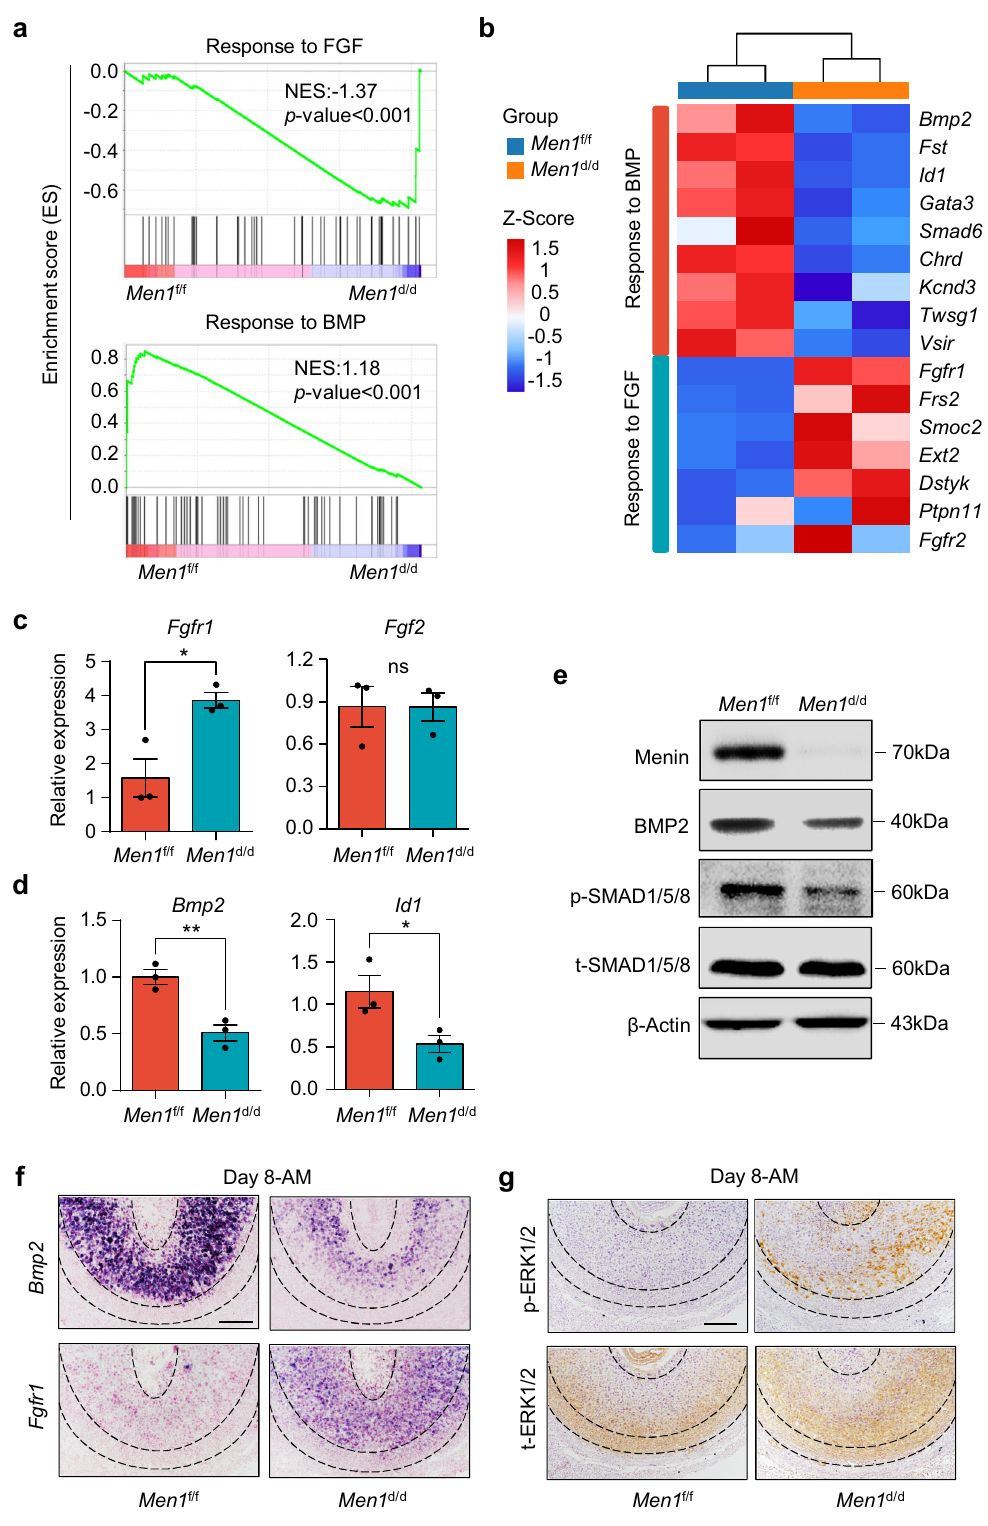
Among the direct targets marked by Menin-H3K4me3 during stroma decidualization, Ptx3 involved in decidualization regula- tion possesses speci fi c expression pattern in the SDZ 41 , but its physiological signi fi cance in stromal cell differentiation remains intangible. Several pieces of evidence showed that PTX3 acted as a natural FGF2 trap through its N-terminal domain to sequester FGF2-ERK1/2 signaling from promoting cell proliferation 42